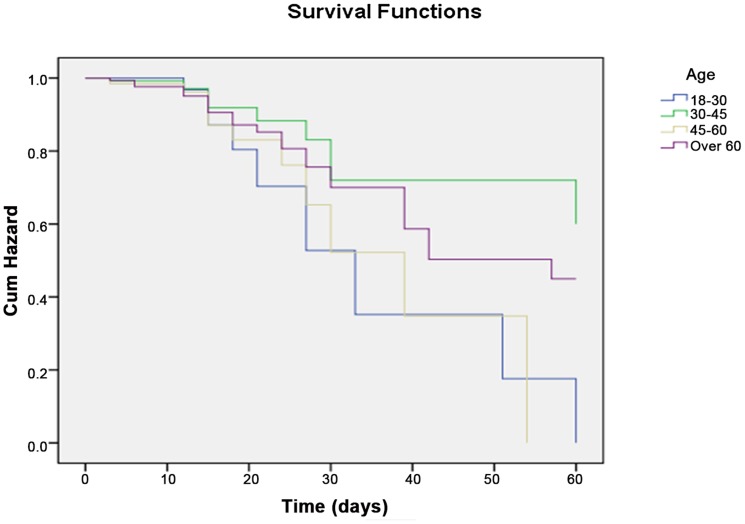
Plot of KM for Age Category.